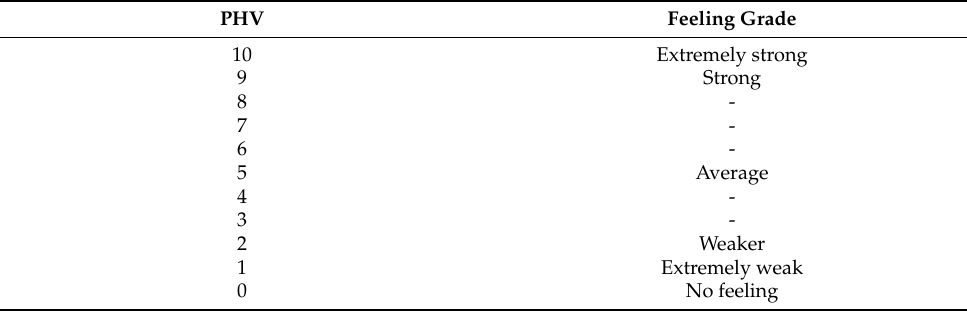
Table 4. Primary Hand Values (PHVs) for fabrics according to the feeling grade.